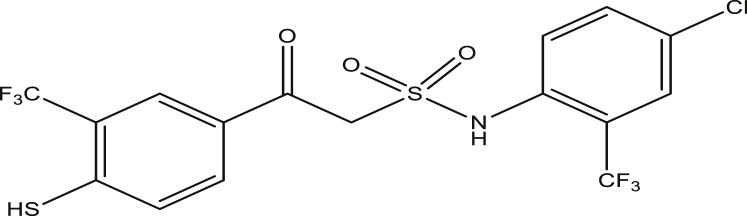
Compound 9c [N-(4-chloro-2-(trifluoromethyl)phenyl)-2-(4-mercapto-3-(trifluoromethyl)phenyl)-2-oxoethanesulfonamide(pEC500.8472726)].